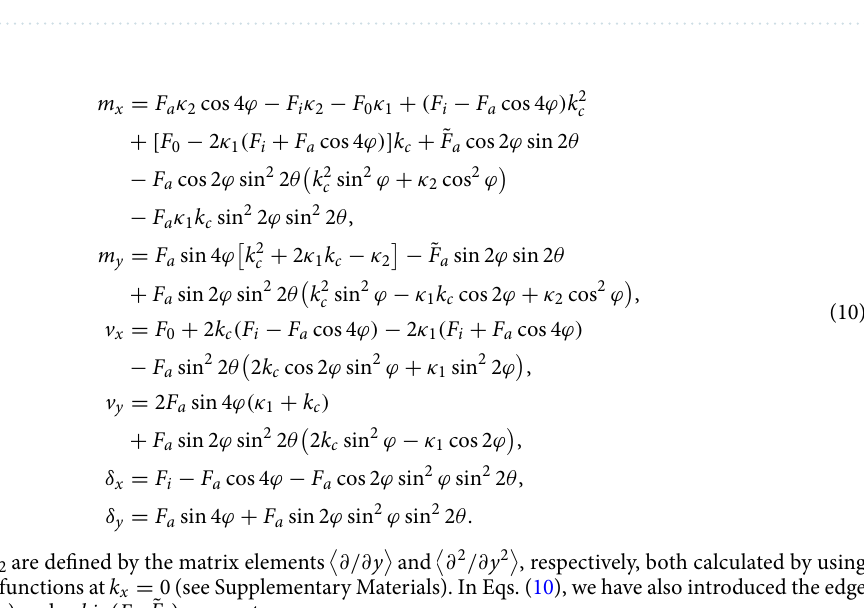
Figure 2. Energy dispersion of the bulk and edge states in the prototype QWs with double band inversion. The ( A ) and ( B ) presents the calculations based on low-energy 1D and 2D Hamiltonians for the (001)-oriented three-layer InAs/GaInSb and double HgTe/CdHgTe QWs, respectively. The layer thicknesses of the prototype QWs are marked by the red symbols in Fig. 1B,C. Bulk states being described by H 2 D ( k x , k y ) in Eq. (1) are shown in black. Red and blue curves correspond to different Kramer’s partners of the edge states. The dashed ( 0 ) curves are the eigenvalues of H 1 D ( k x ) in Eq. (8). The wave vector and the edge are oriented along (100) crystallographic